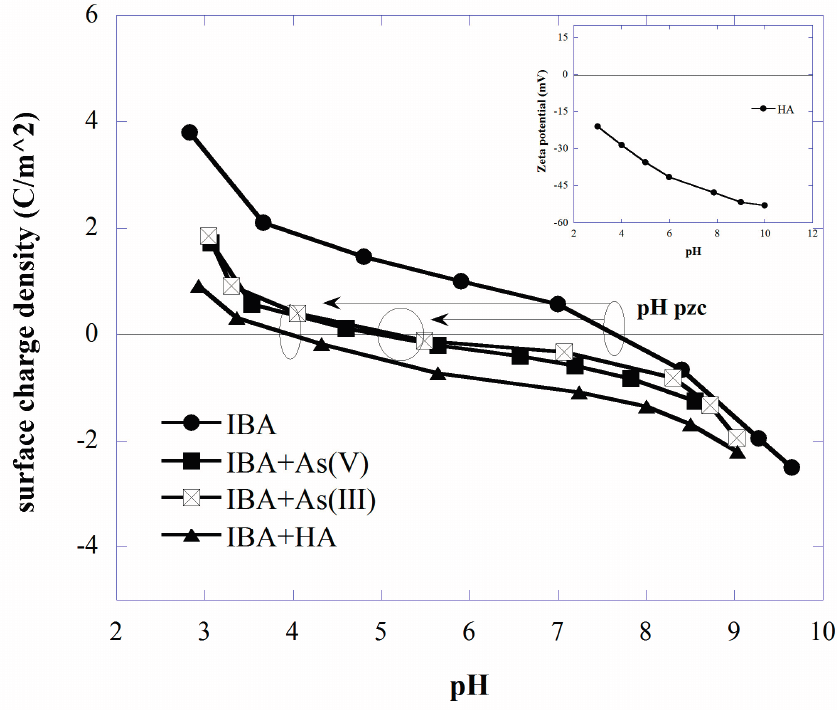
Figure 1. Zeta potentials of HA and surface charge density curves of bare IBA and IBA preloaded with As(III), As(V) and HA at different pH